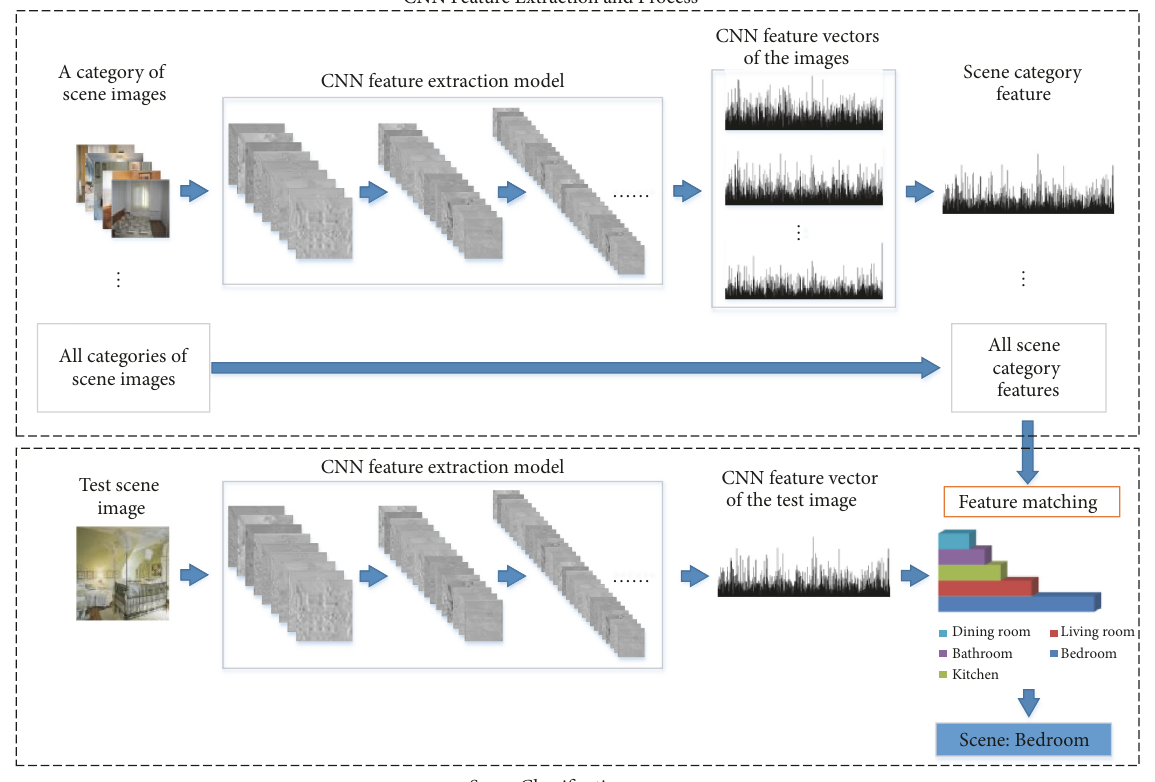
Figure 1: Overall framework of the proposed indoor scene classification method based on CNN feature. There are two parts in the framework. The first part is to generate scene category features by CNN feature extraction and process. The second step is to match CNN feature vector of the test scene image with the scene category features by a new feature matching algorithm to generate scores of different scenes. The largest score indicates the result of scene classification. For example, the category of the test scene image is bedroom with the highest score in Figure